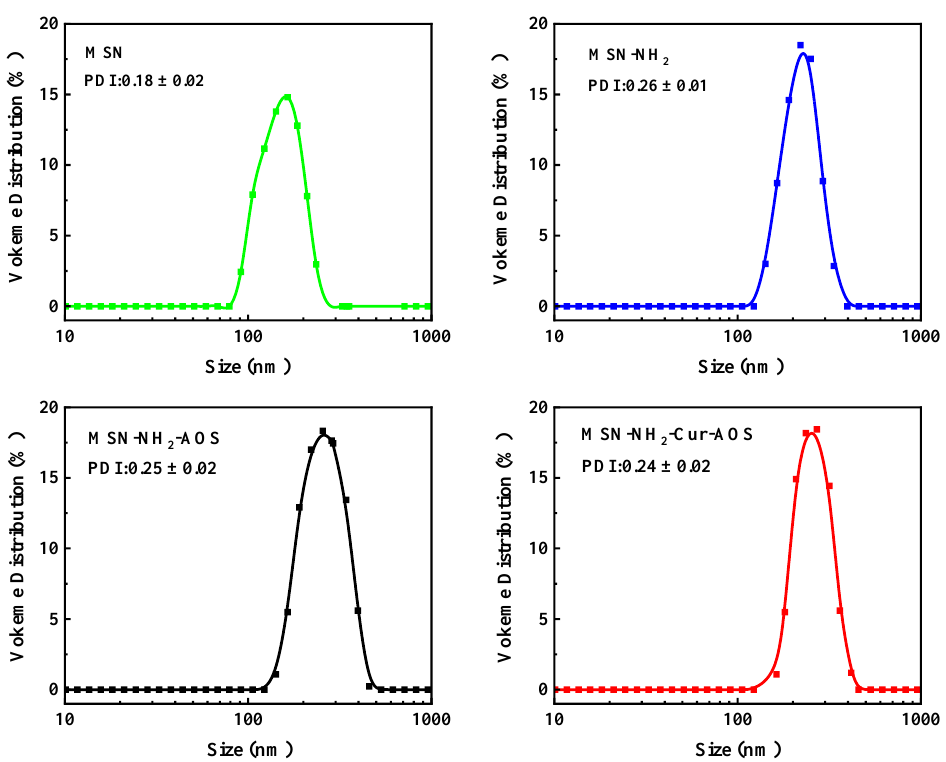
Figure 7. DLS graphs of MSN, MSN-NH 2 , MSN-NH 2 -AOS, and MSN-NH 2 -Cur-AOS.